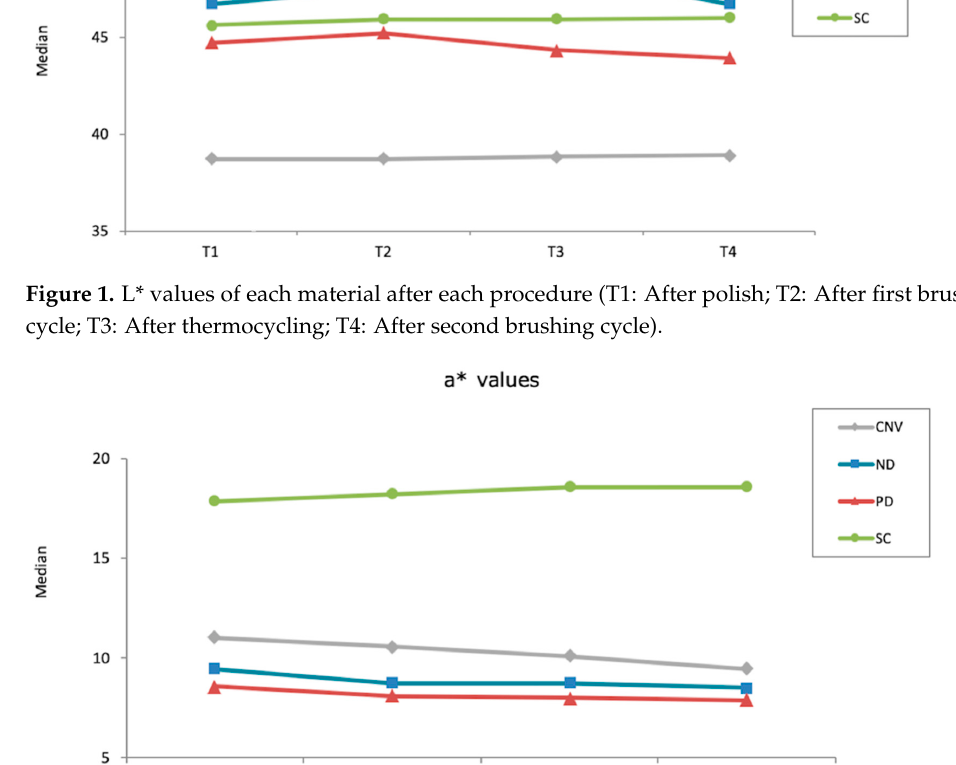
Figure 3. b* values of each material after each procedure (T1: After polish; T2: After first brushing cycle; T3: After thermocycling; T4: After second brushing cycle). 4. Discussion R a values were significantly affected by the material type. Even though statistical analyses revealed that there were no significant differences among different time intervals within each material, the authors believe that there was a tendency towards lower R a when before polish values were compared with those of other time intervals for most of the materials (Table 2). Given that the p-values of Wilcoxon tests were resulted from Bonfer- roni correction, which is a rather conservative analysis [36] it may be assumed that there were significant differences among different time intervals within each material. There- fore, first null hypothesis was accepted. Even though no significant differences were ob- served among Δ E 00 values at different time intervals within materials, material type af- fected Δ E 00 values within different time intervals. Thus, the second null hypothesis was also accepted. None of the materials tested in the present study had R a values similar to or lower than previously described clinical threshold value of 0.2 µm [16]. However, PD had sig- nificantly lower R a than those of other materials before polish, which could be attributed